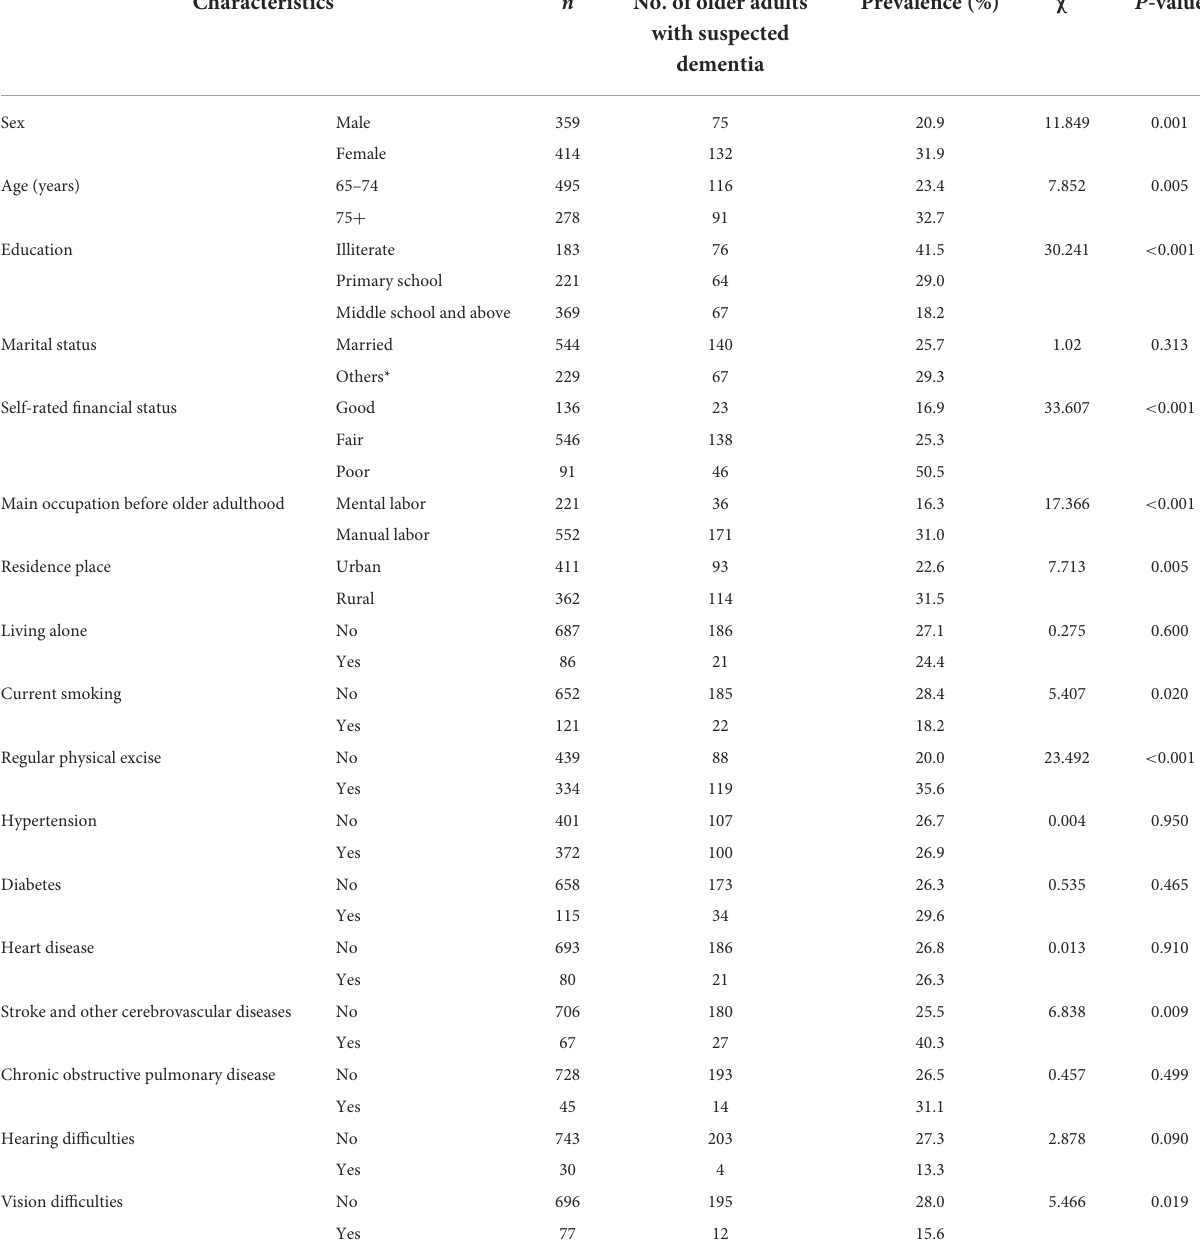
TABLE 1 Characteristics of the sample of older adults receiving primary healthcare and prevalence rates of suspected dementia by factor. Characteristics n No. of older adults Prevalence (%) χ 2 P with suspected dementia